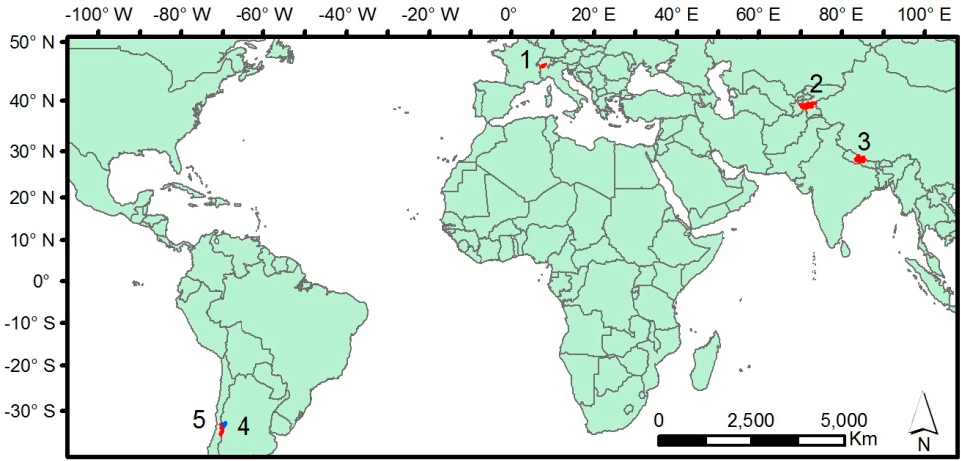
Figure 1. Location of five river basins: (1) Upper Rhone, (2) Vakhsh, (3) Narayani, (4) Mendoza, and (5) central Chile.